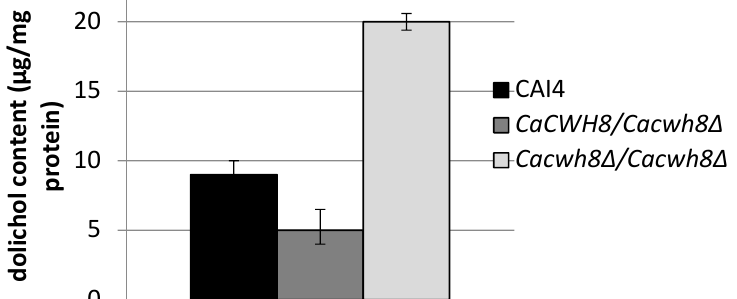
Figure 2. Dolichol content in the wild type C. albicans strain CAI4 and CaCWH8 mutants. Data are mean ± standard deviation from three independent experiments.